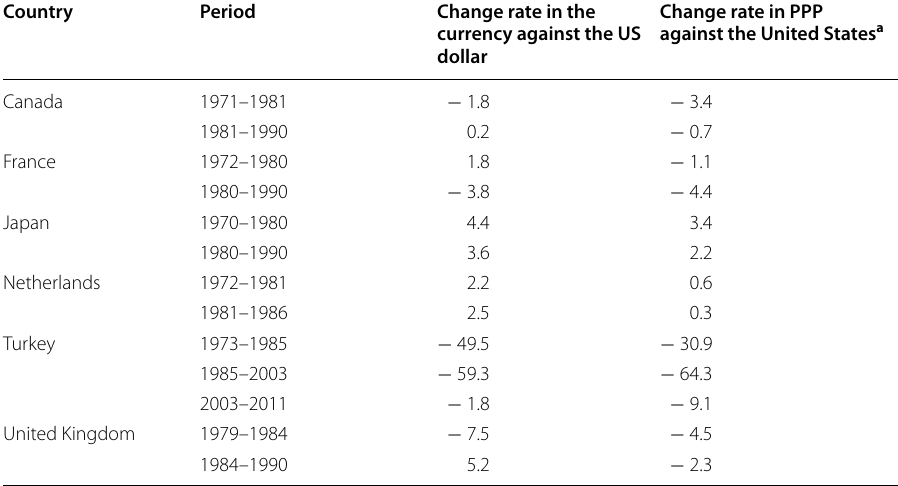
Table 2 Change rate in the currency and PPP against the United States (annual rate, unit: %). Source: Author’s calculations. See Sect. 2.2 for the calculation of PPP. The change rates in nominal exchange rates were derived from the Federal Reserve Bank of St. Louis (exchange rate to US Dollar) Country Period Change rate in the currency against the US